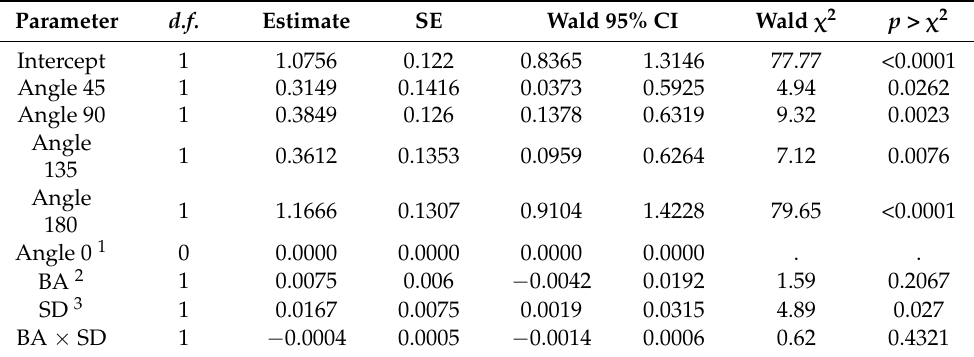
Table 4. Parameter estimates for generalized linear model results of synthetic bat echolocation playback response within an anechoic chamber to detector angle ( ◦ ) and simulated clutter variation represented by basal area (m 2 /ha) and stem density (stem count) for mean frequency (Fmean), Blacksburg, VA, USA, 2016. Detectors recorded in full spectrum (see text for details). Parameter d.f.